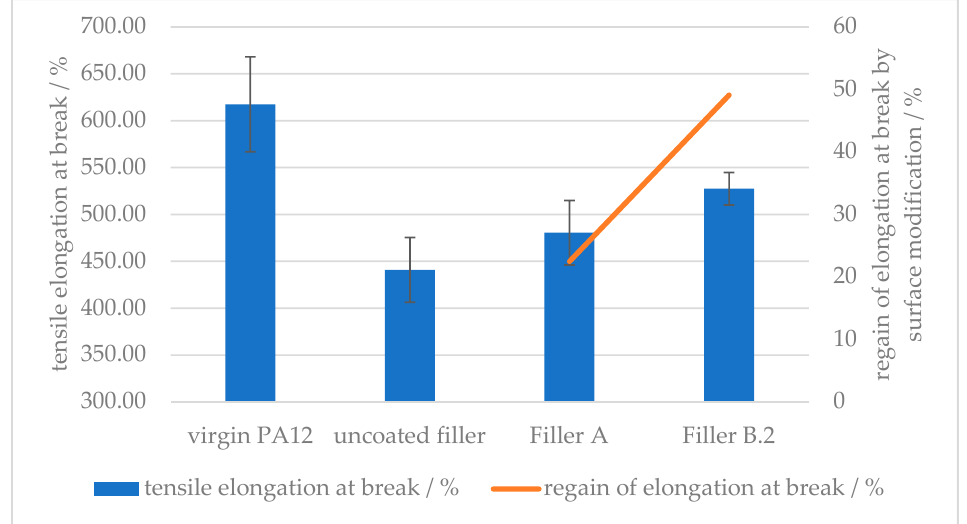
Figure 9. Effect of the surface modifier chemistry on the elongation at break of ( A ) stearic acid and ( B ) amino hexanoic acid treated CaCO 3 -filled PA12 composites.